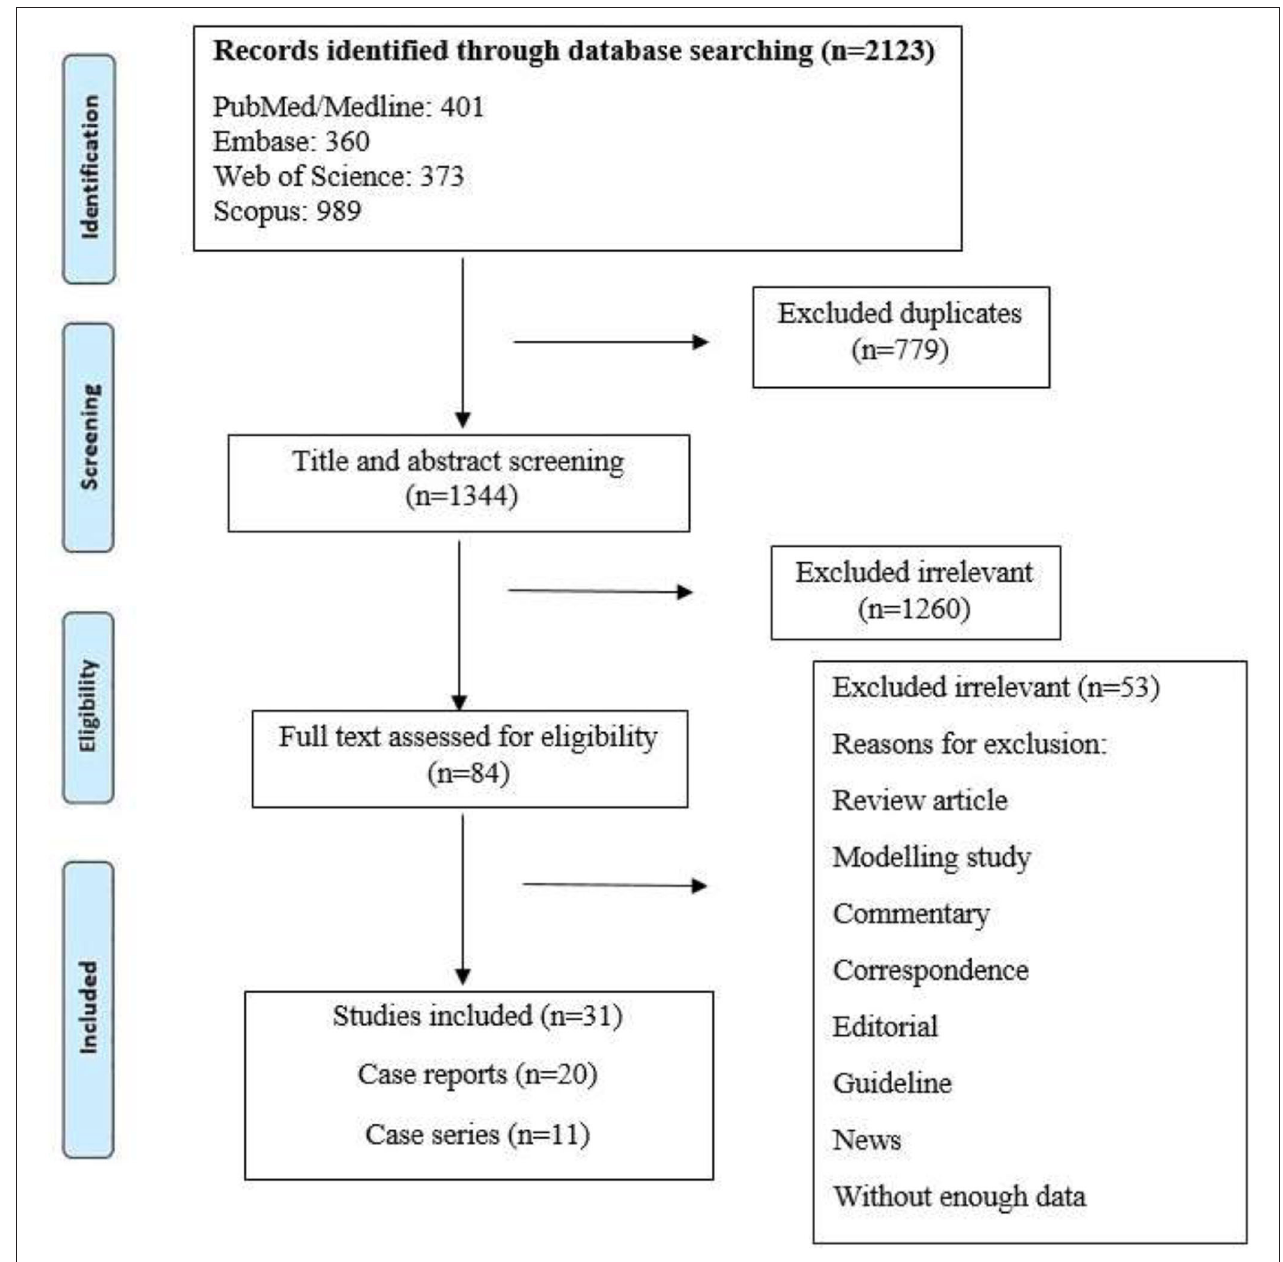
FIGURE 1 | Flow diagram detailing review process and study